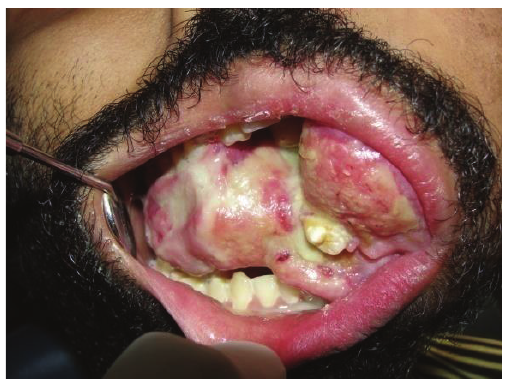
Figure 3: Intraoral view depicting the growth.